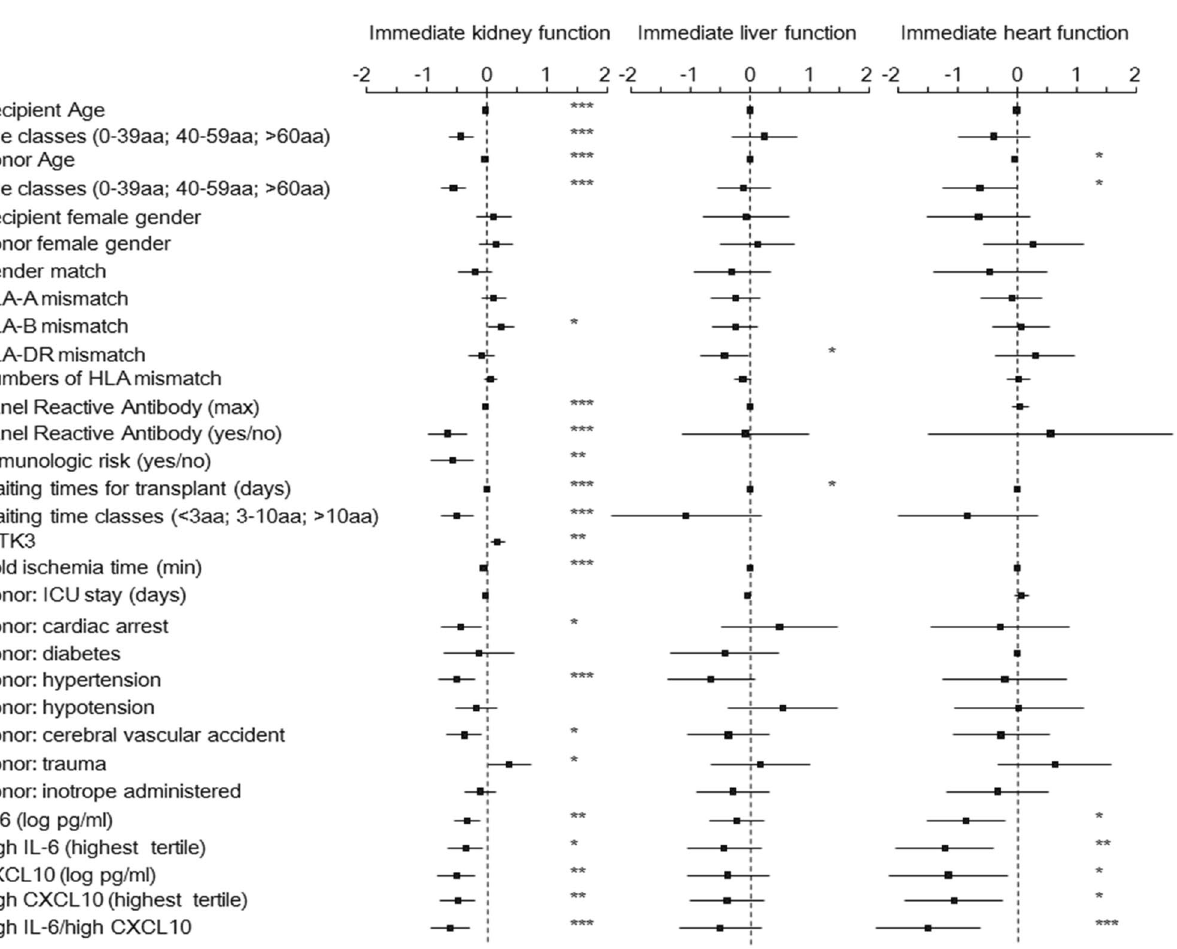
Figure 2. Univariate odd ratios for immediate graft function (IGF). The association between donor IL-6 and CXCL10, baseline variables and immediate graft function was assessed by a logistic regression analysis including patients receiving kidney, liver or heart transplant. All analyzed variables are presented. Dots represent the odds ratio (OR) after natural log transformation, lines the 95% confidence intervals. *p < 0.05; **p < 0.01; ***p <